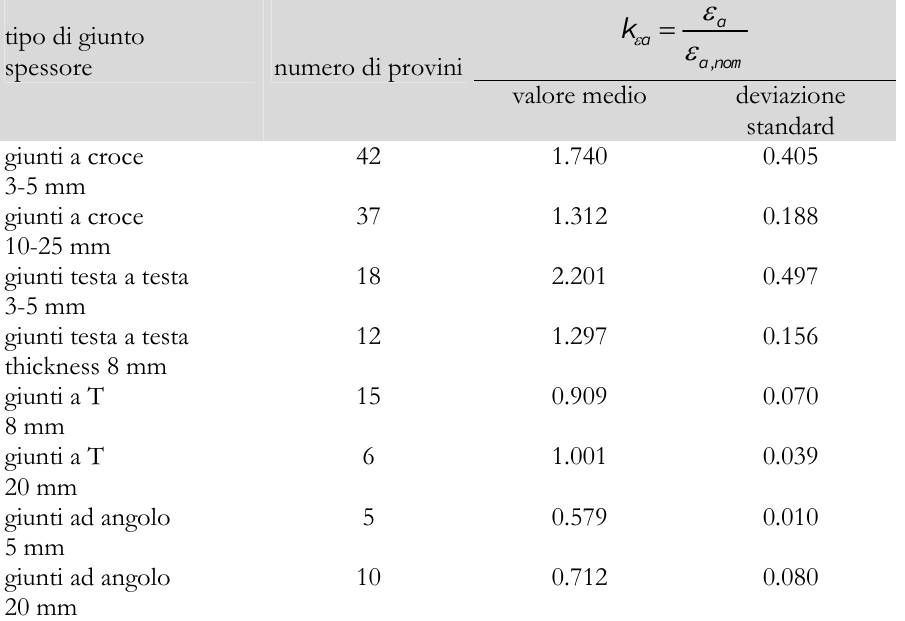
Tabella 2: Valore caratteristici del coefficiente di amplificazione locale della